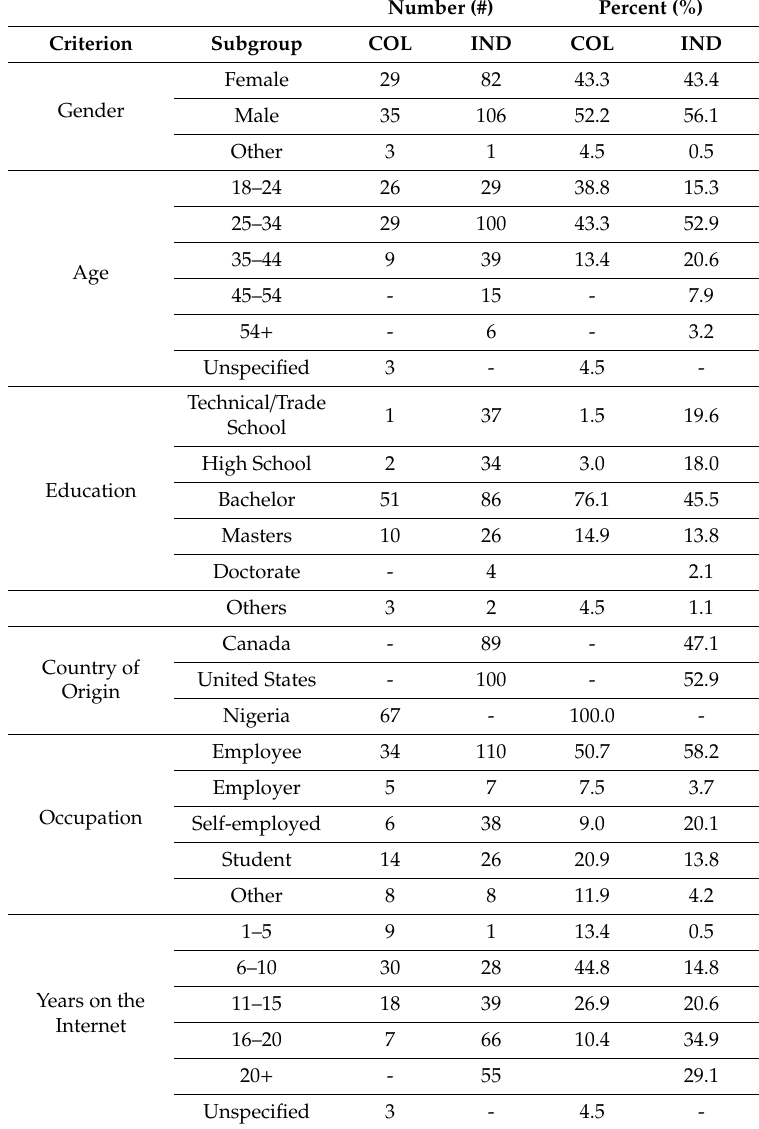
Table 2. Demographics of participants. COL = Collectivist culture, IND = Individualist